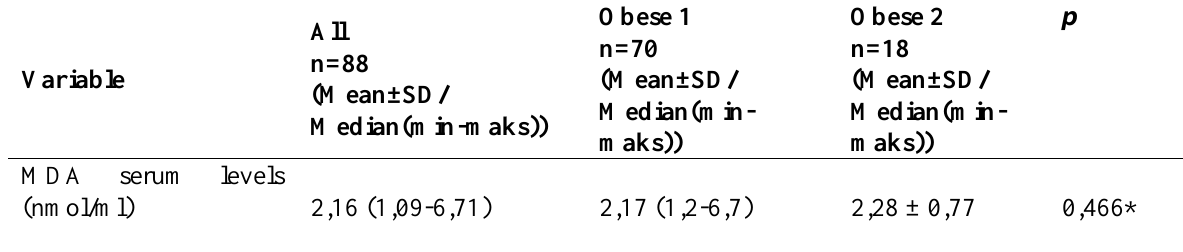
Table 3. Subject’s malondialdehyde serum levels